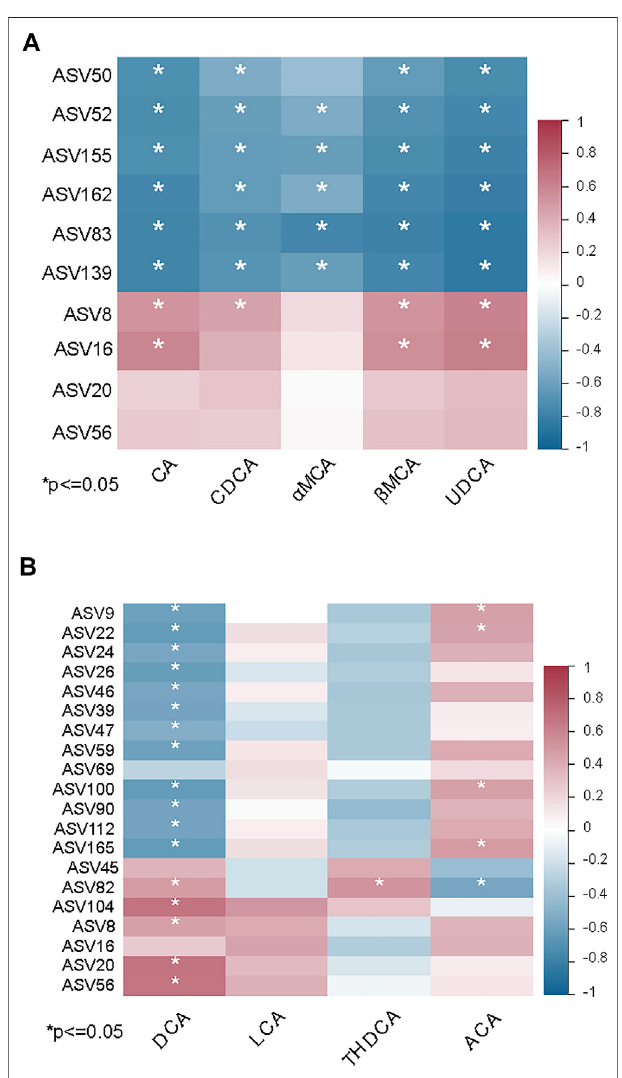
FIGURE 6 | Associations between the gut microbiome and bile acid levels in MCD diet induced NASH mice. (A) Heatmap showing the correlation between primary bile acids and differentially abundant ASVs in MCS and MCD-fed mice. (B) Heatmap showing the correlation between secondary bile acids and differentially abundant ASVs in MCD-fed mice with and without rifaximin treatment. Asterisk refers to the signi fi cant negative or positive correlation. * p < 0.05 (Spearman ’ s correlation analysis). The r value is represented by gradient colors. n = 7 mice in each group.